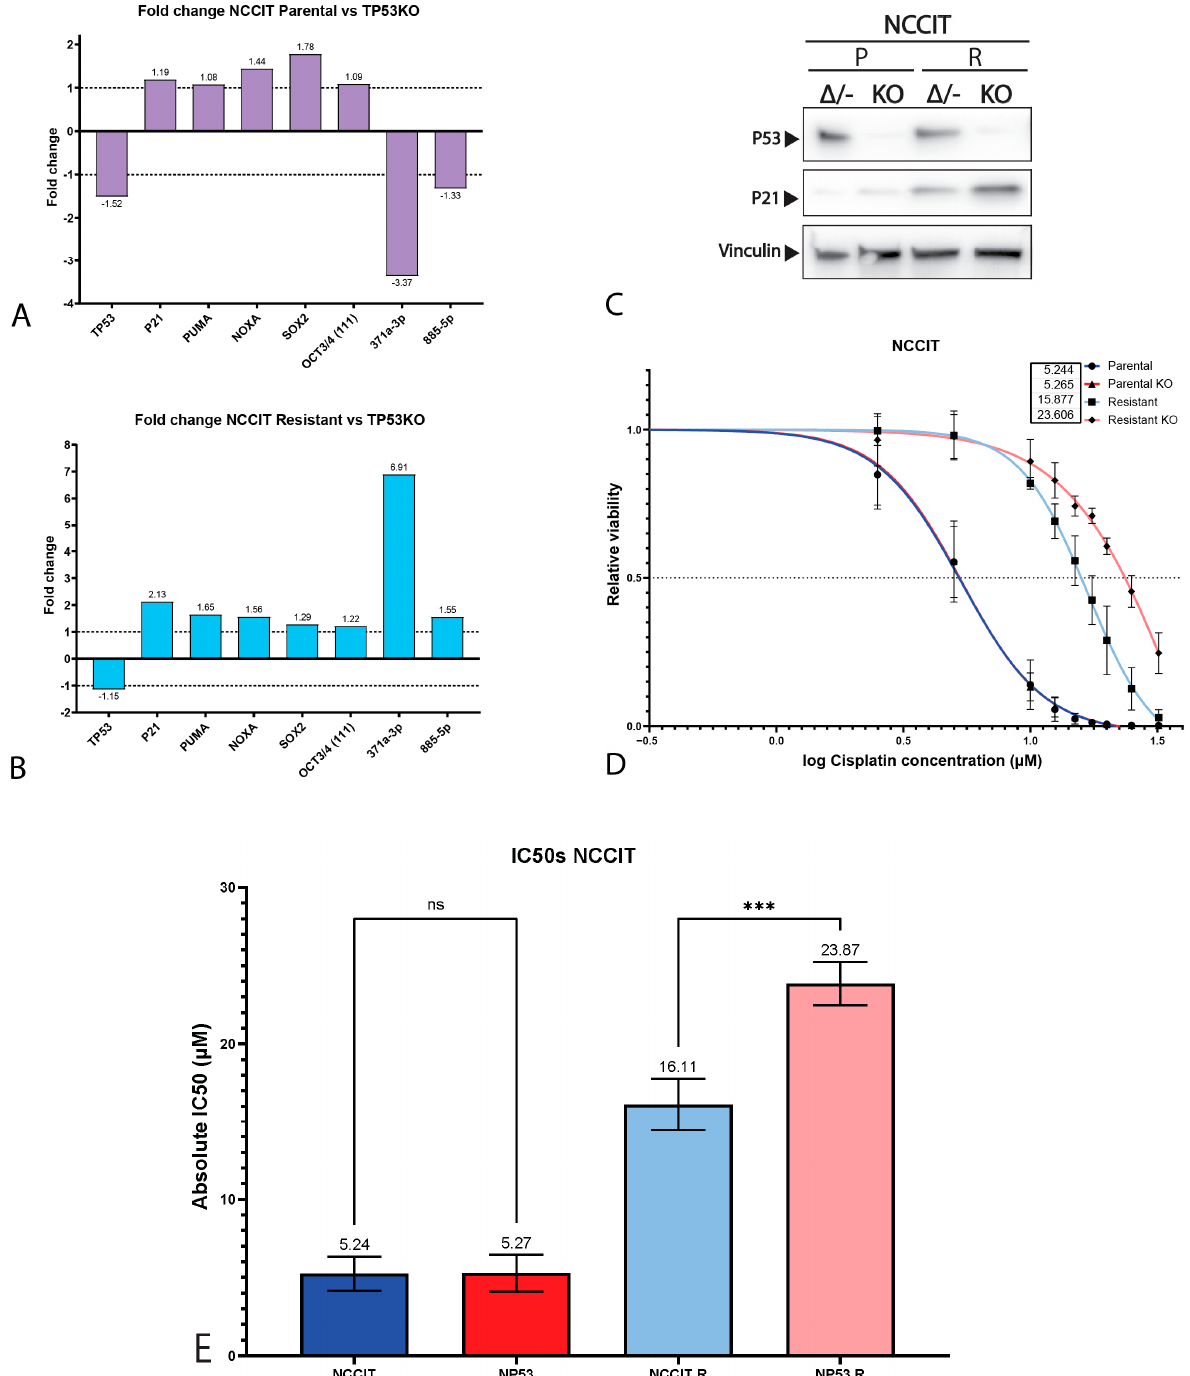
Figure 4. Characterization of NCCIT TP53 knock-out cell lines. ( A , B ) Bar graphs showing the fold change in expression between NCCIT parental cell line and its isogenic TP53 knock-out clone ( A ) or NCCIT-resistant cell line and its isogenic TP53 knock-out clone ( B ). ( C ) Western blots showing the protein levels of P53, P21 and vinculin (as loading control) in NCCIT parental and resistant cell lines and their isogenic TP53 knock-out clones. ( D ) S-curves showing the viability of the NCCIT cell lines (parental and resistant and TP53 knock-out lines) when treated with cisplatin for 72 h. Graphs represent three biological replicates with three techinical replicates each. ( E ) Bar plots displaying IC50 values of all NCCIT cell lines. The NCCIT-resistant cell line shows a significant difference in IC50 values after knock-out ( p = 0.0005, one-way ANOVA, Tukey’s multiple comparisons post hoc test). Mean ± SD: NCCIT parental 5.24 ± 1.09, NCCIT parental TP53 KO 5.27 ± 1.18, NCCIT resistant 16.11 ± 1.67, and NCCIT resistant TP53 KO 23.87 ± 1.38. ns = p > 0.05, *** p ≤ 0.001.